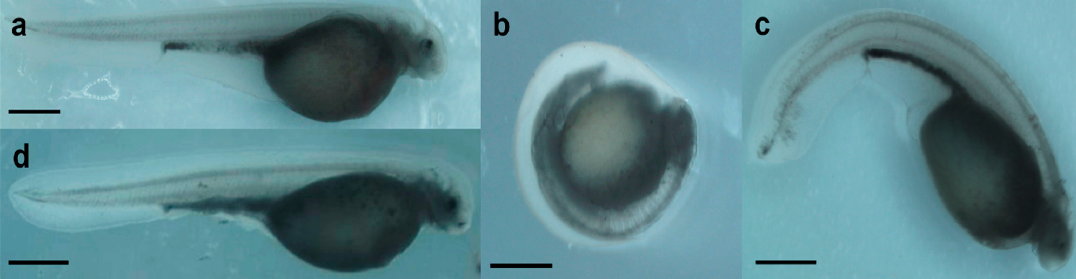
Figure 3. Sterlet ( A. ruthenus ) embryo phenotypes observed at 8 dpf following exposure to olaparib (Ola) at 2–24, 24–48, and 48–72 hpf. ( a ) Control; ( b ) Ola 2–24; ( c ) Ola 24–48; ( d ) Ola 48–72. Images are representative of embryo culture. Scale bars = 1 mm.